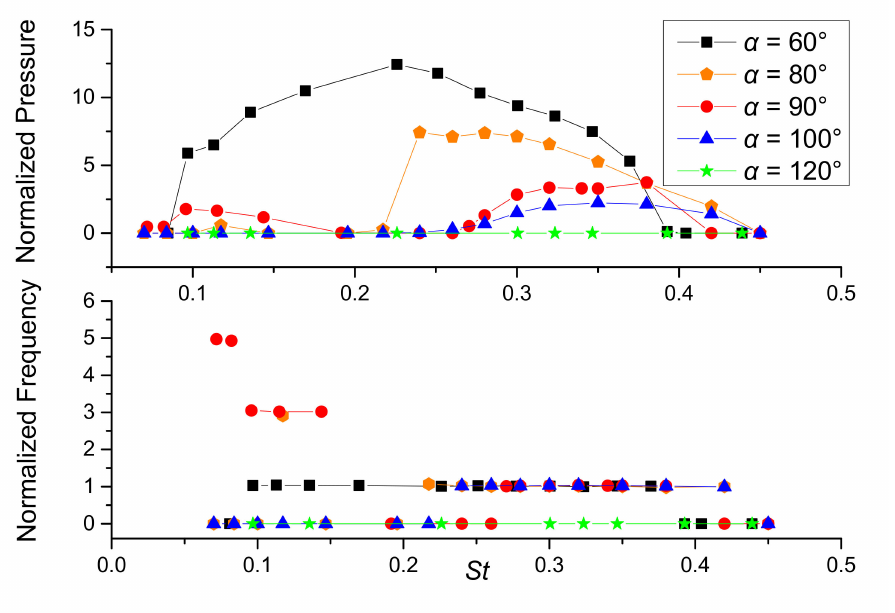
Figure 12. Variation of pressure fluctuation with